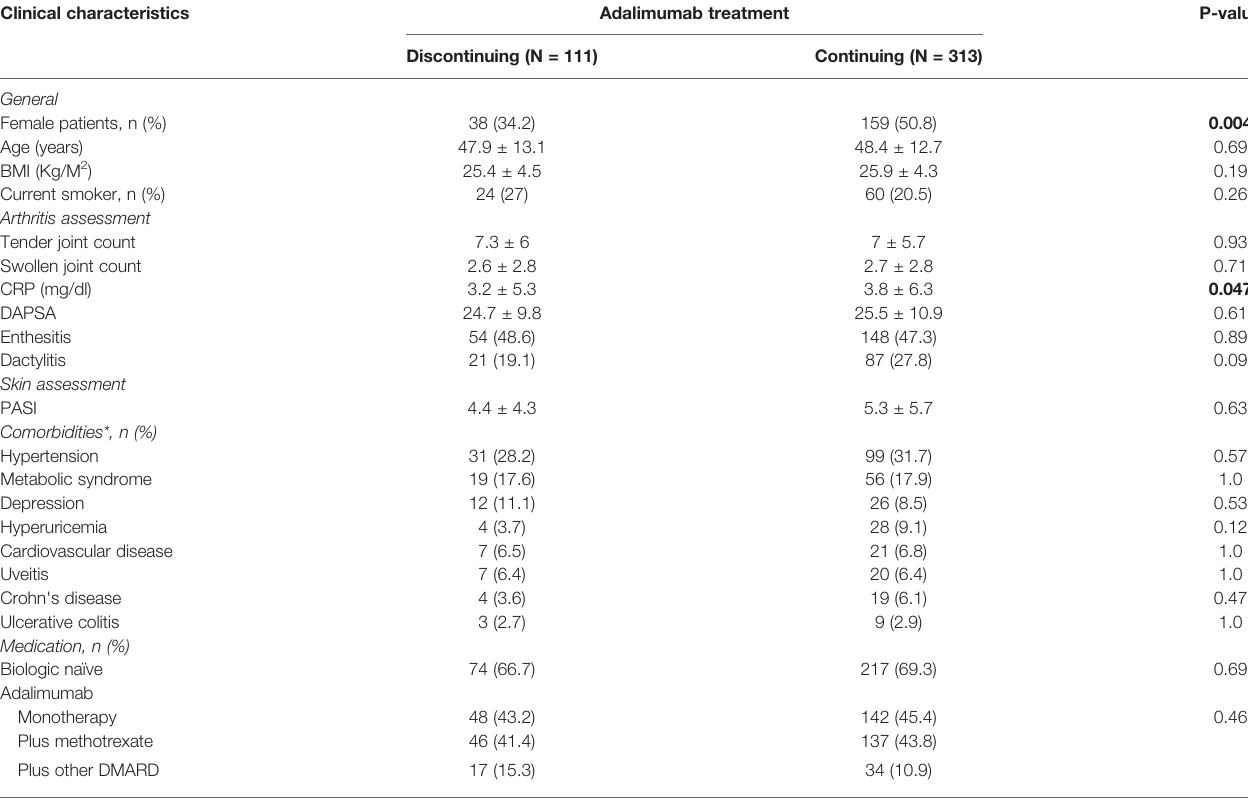
TABLE 2 | Predictor variables of adalimumab persistence at 24